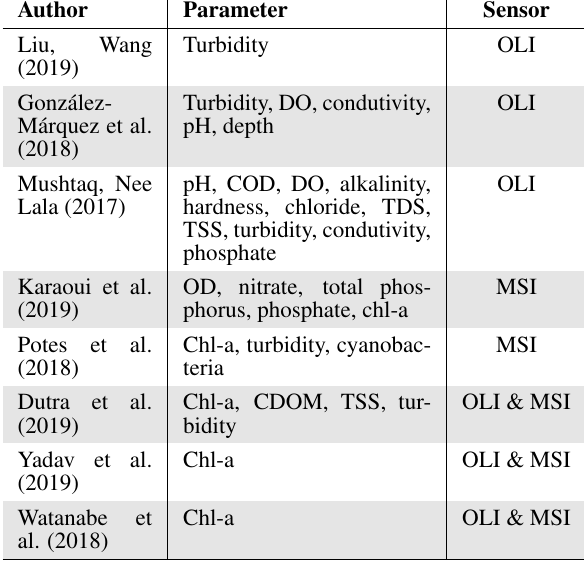
Table 1. Water quality studies using MSI, OLI or both.